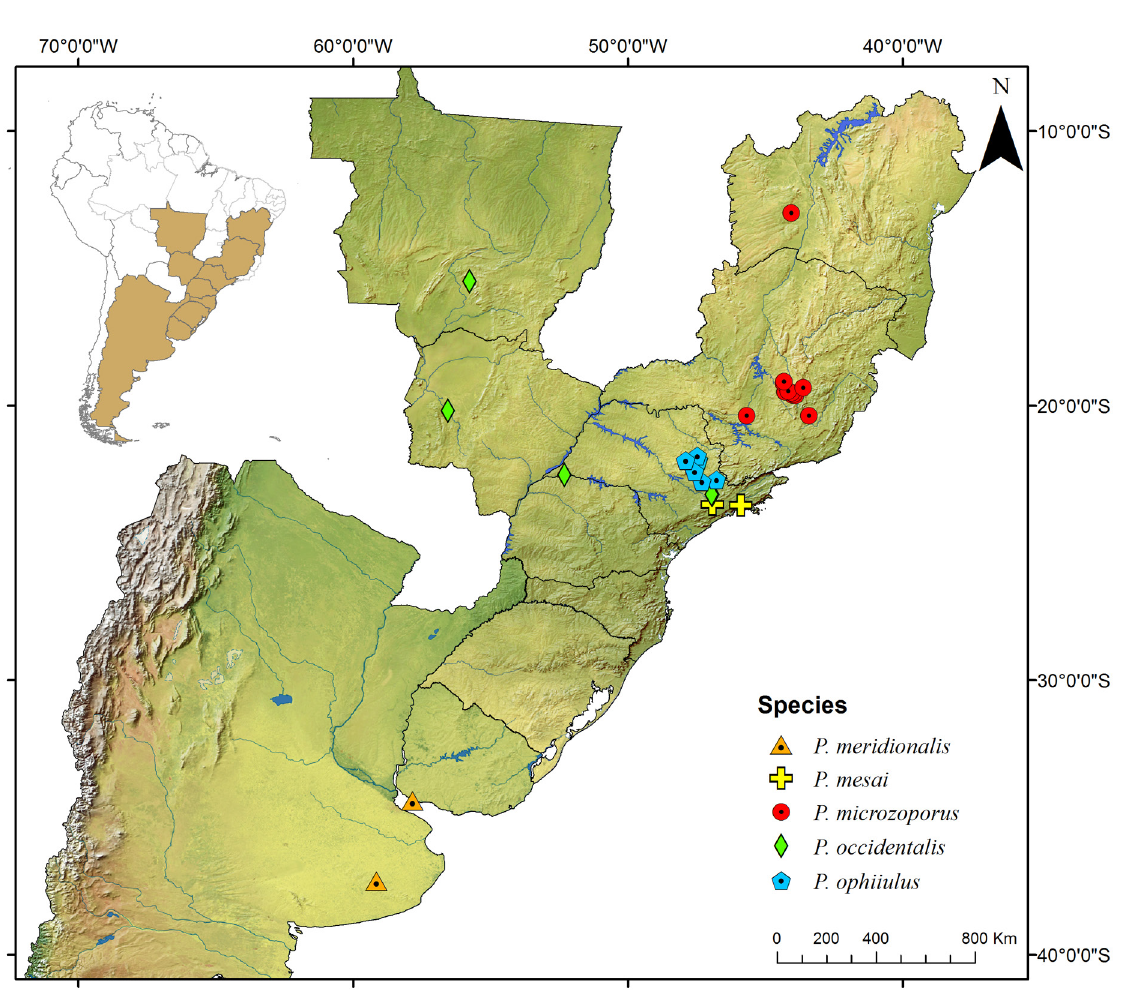
Fig. 185. Distribution map of the species Pseudonannolene meridionalis Silvestri, 1902, P. mesai Fontanetti, 2000, P. microzoporus Mauriès, 1987, P. occidentalis Schubart, 1958, and P. ophiiulus Schubart,